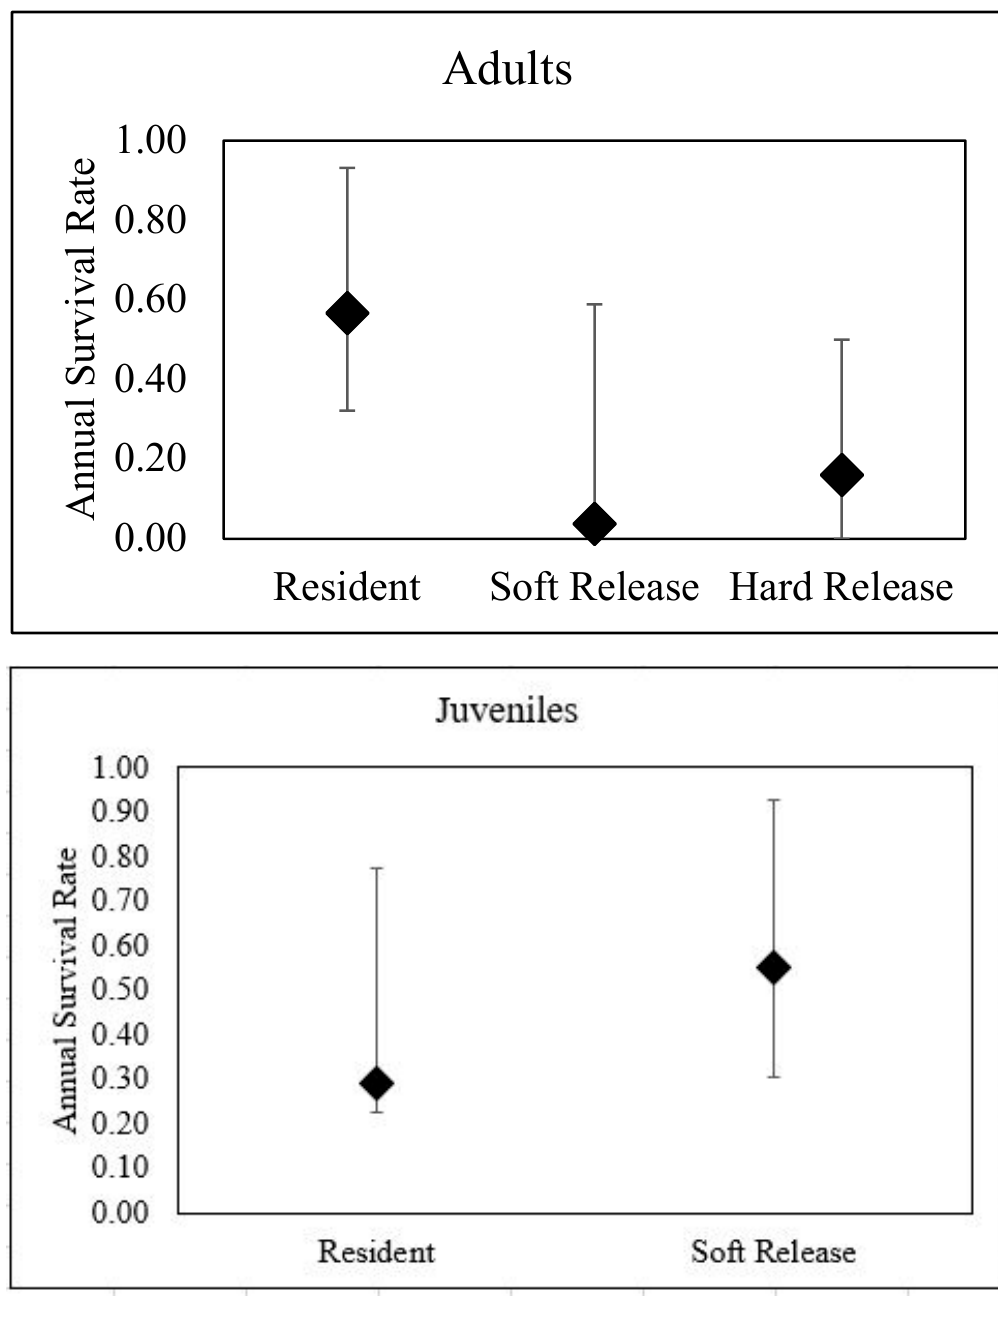
Figure 3. Estimated annual survival rates ( ± 95% CI) for resident, soft-released, and hard-released adults ( top ) and juvenile ( bottom ) Texas horned lizards on Tinker Air Force Base, OK. Survival estimates for hard-released adult lizards come from 17 adult lizards translocated and tracked in 2008 [23].